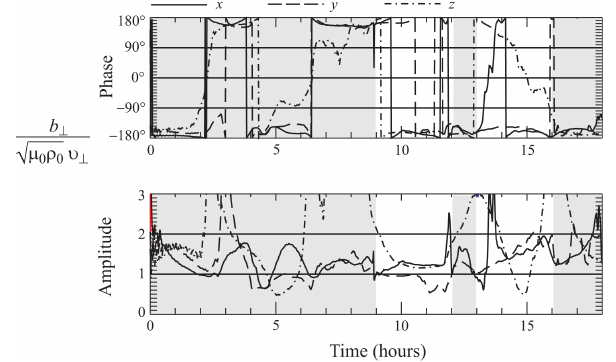
√ µ 0 ρ 0 v ⊥ . Upper